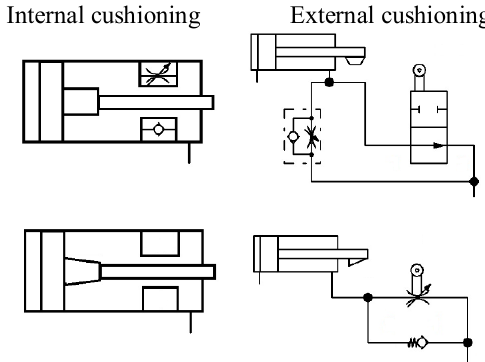
Fig. 8. I mplementation of external cushioning